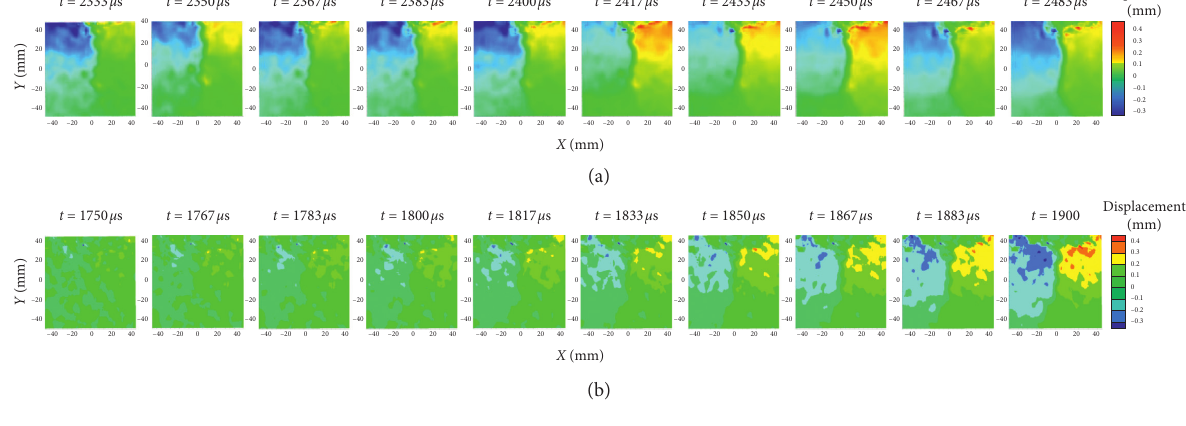
Figure 15: Evolution of horizontal displacement field. (a) Test 1 and (b) test 3.